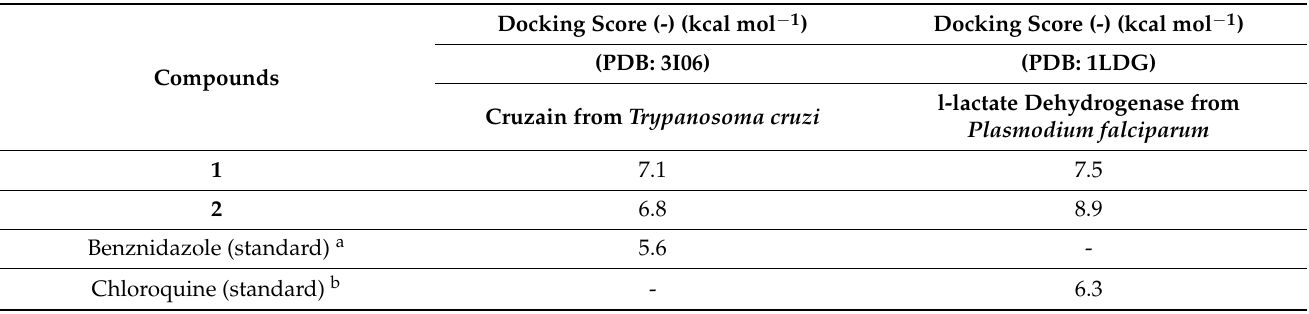
Figure 5. ( a ) Binding site (yellow colour) of cruzain from Trypanosoma cruzi. ( b ) Binding site (yellow colour) l-lactate dehydrogenase from Plasmodium falciparum . Table 2. Docking analysis of two ligands on two different protein receptors with respect to benznidazole and chloroquine standard.